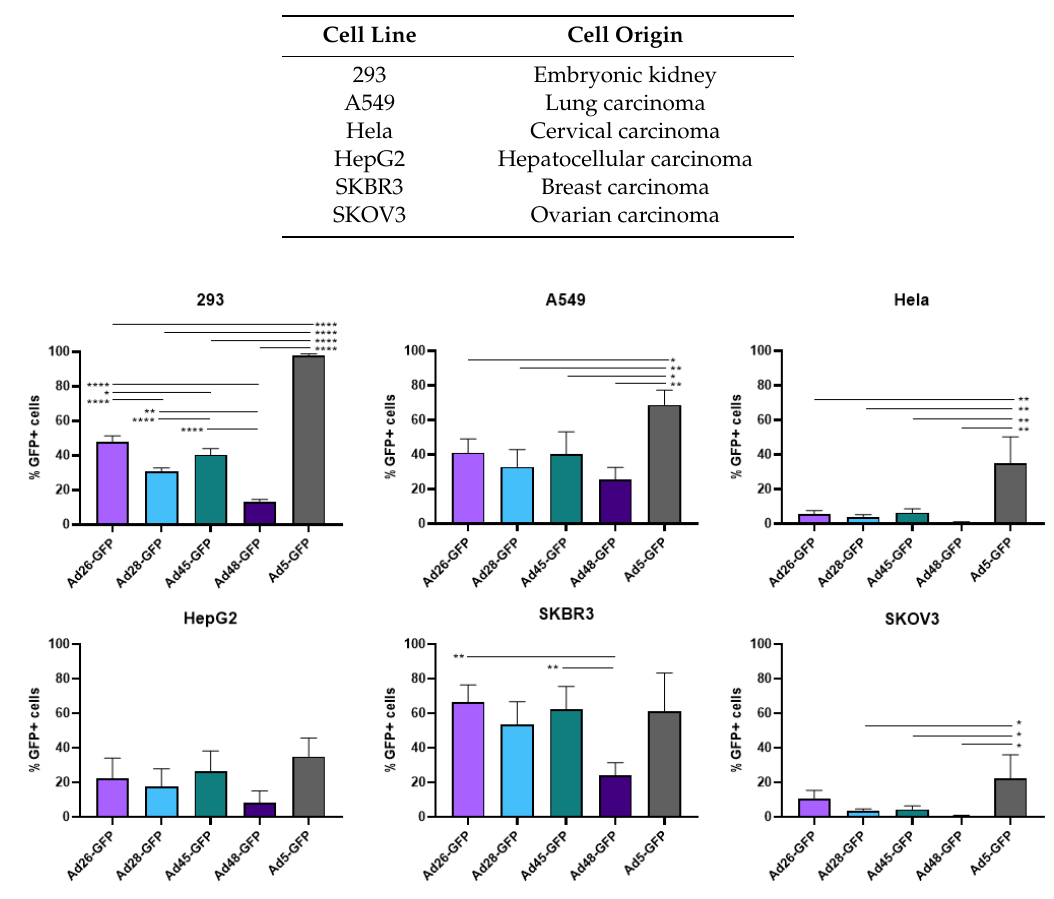
Figure 3. Viral transduction of the recombinant species D Ads or Ad5 GFP-Luc viruses. The transduction of the Ad-GFP-Luc virus was examined by infecting cells with the indicated viruses at 500vp/cell and determining GFP+ cells at 24 h post infection using flow cytometry. Data is presented as mean ± standard deviation (SD) from three independent experiments (* p < 0.05, ** p < 0.01, **** p < 0.0001; one-way ANOVA).